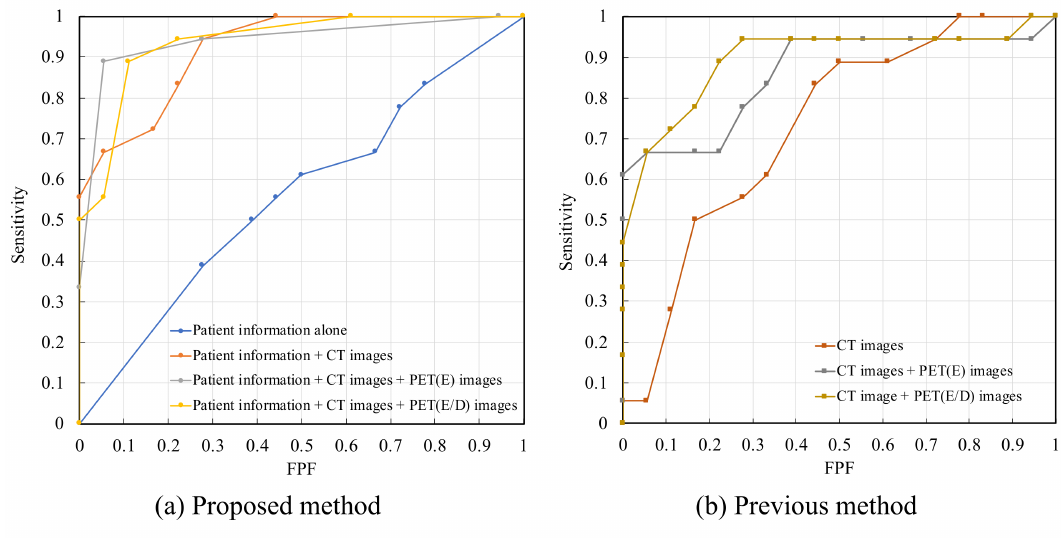
Figure 2. Receiver operating characteristic (ROC) curves; ( a ) Proposed method; ( b ) Previous